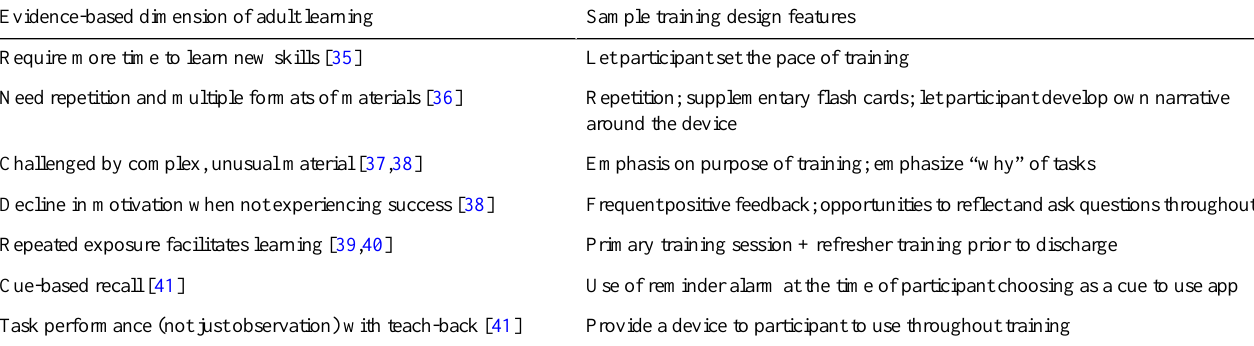
Table 2. Tenets of adult learning and memory and corresponding training design features.